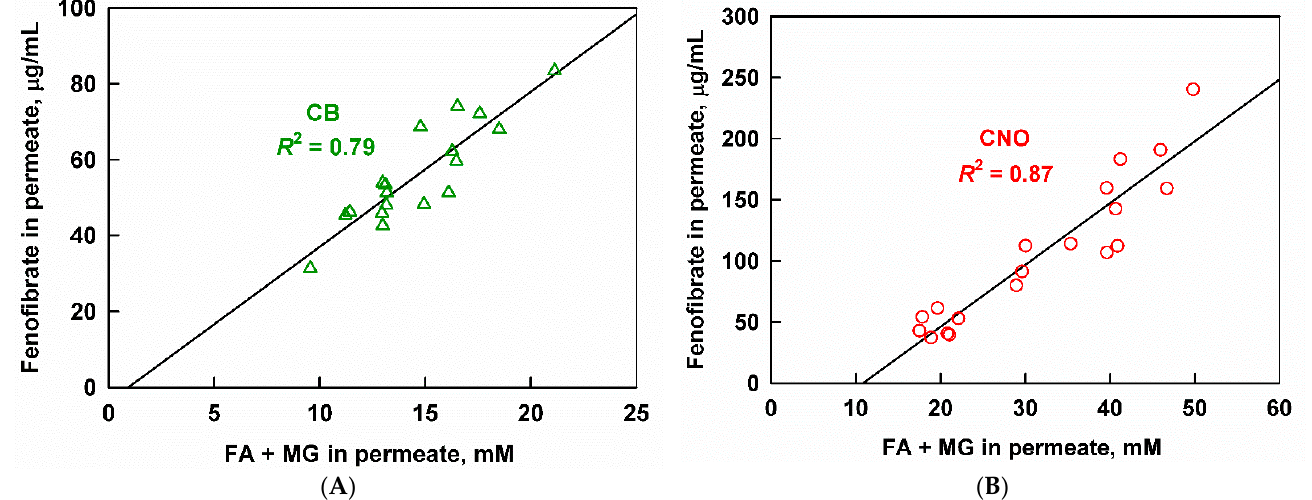
Figure 11. Aqueous fenofibrate as a function of the sum of fatty acids (FA) and monoglycerides (MG) measured in the aqueous phase after in vitro digestion of ( A ) cocoa butter and ( B ) coconut oil emulsions. Relatively good linear correlations were observed for CB ( R 2 = 0.79) and CNO ( R 2 = 0.87) when the sum of all FA and MG was used. Worse correlations were obtained when